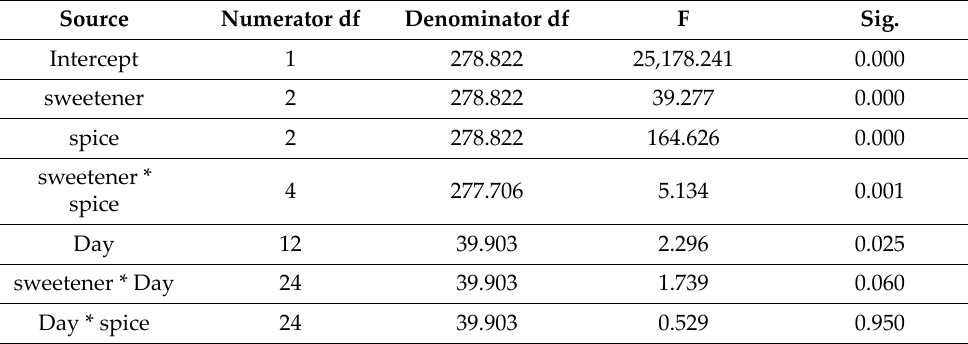
Table A1. Type III Tests of Fixed Effects for Total Phenolics Content (from SPSS).